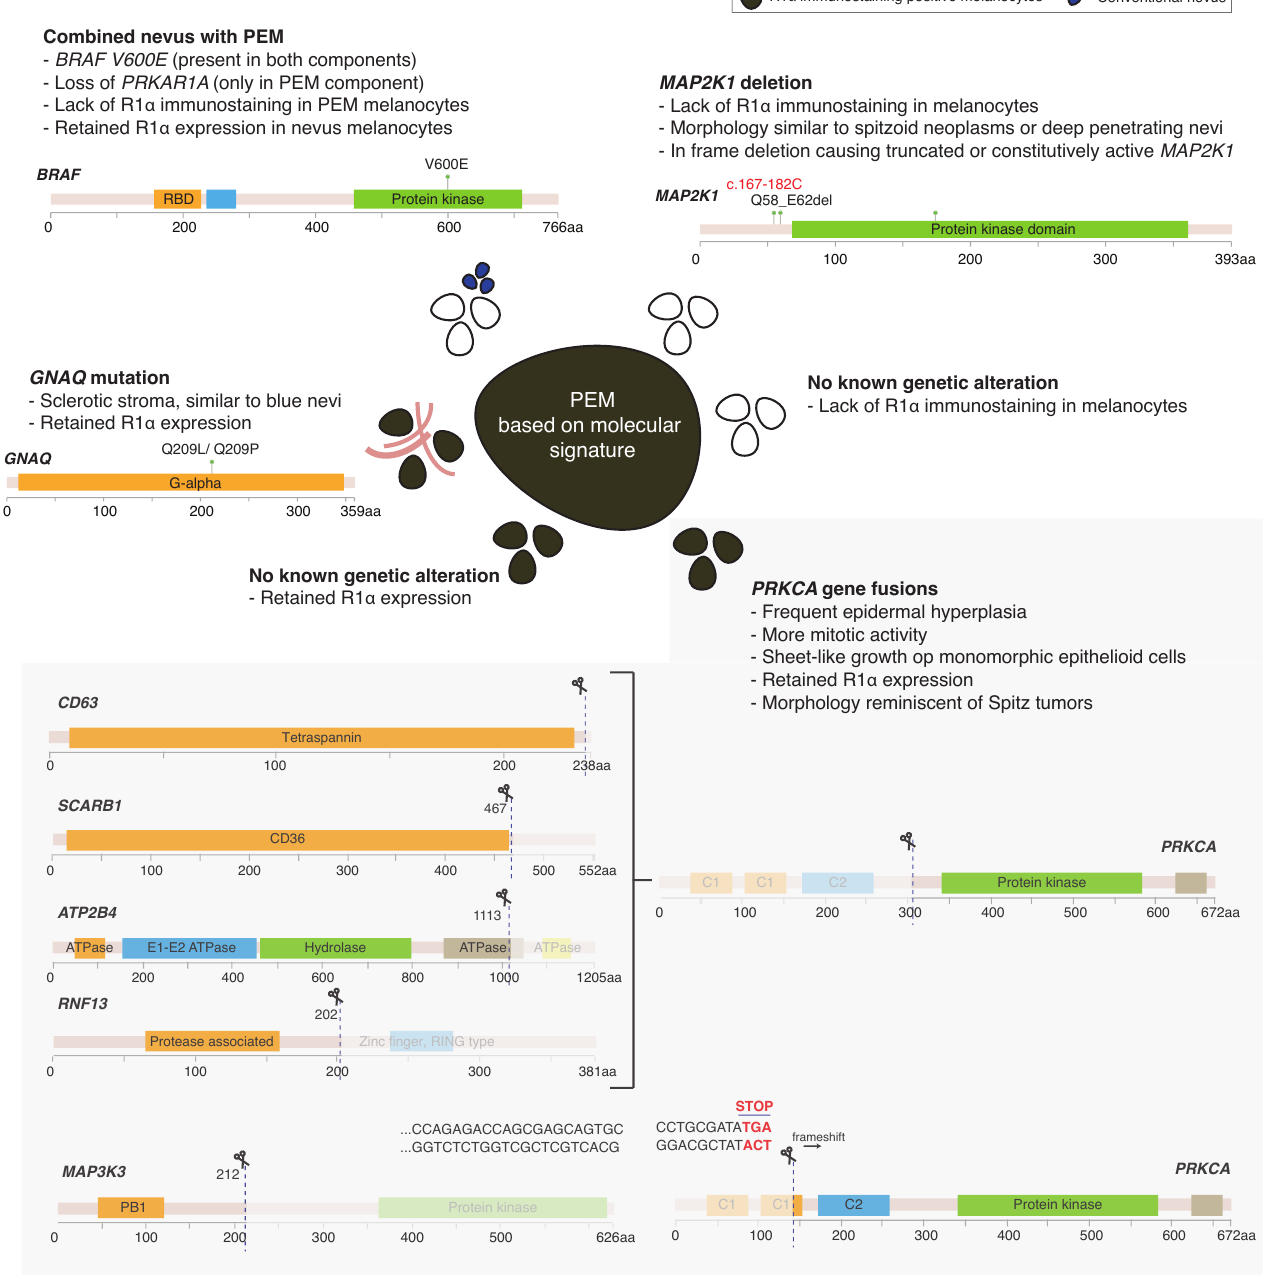
Figure 1. Different molecular subtypes of